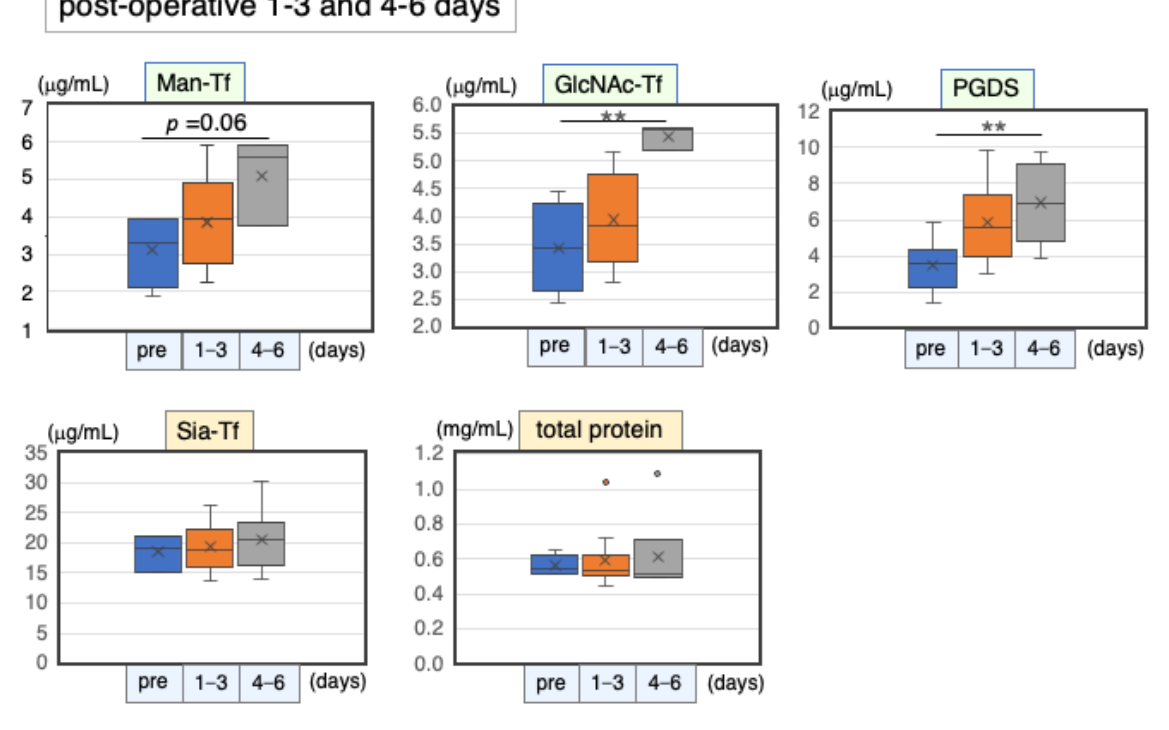
Figure 8. CSF marker levels at post-operative days 1–3 and 4–6. Horizontal lines within boxes show median values; boxes exclude upper and lower interquartile ranges; whiskers indicate maximum and minimum values. Outliers are indicated by dots. Probability level: ** p < 0.01. Table 9. CSF marker levels at post-operative days 1–3 and 4–6.